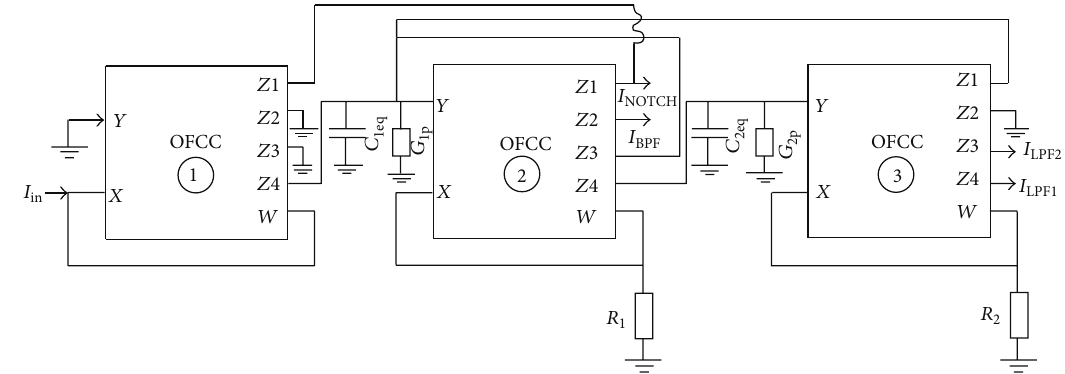
Figure 5: Proposed OFCC based current mode filter with parasites.